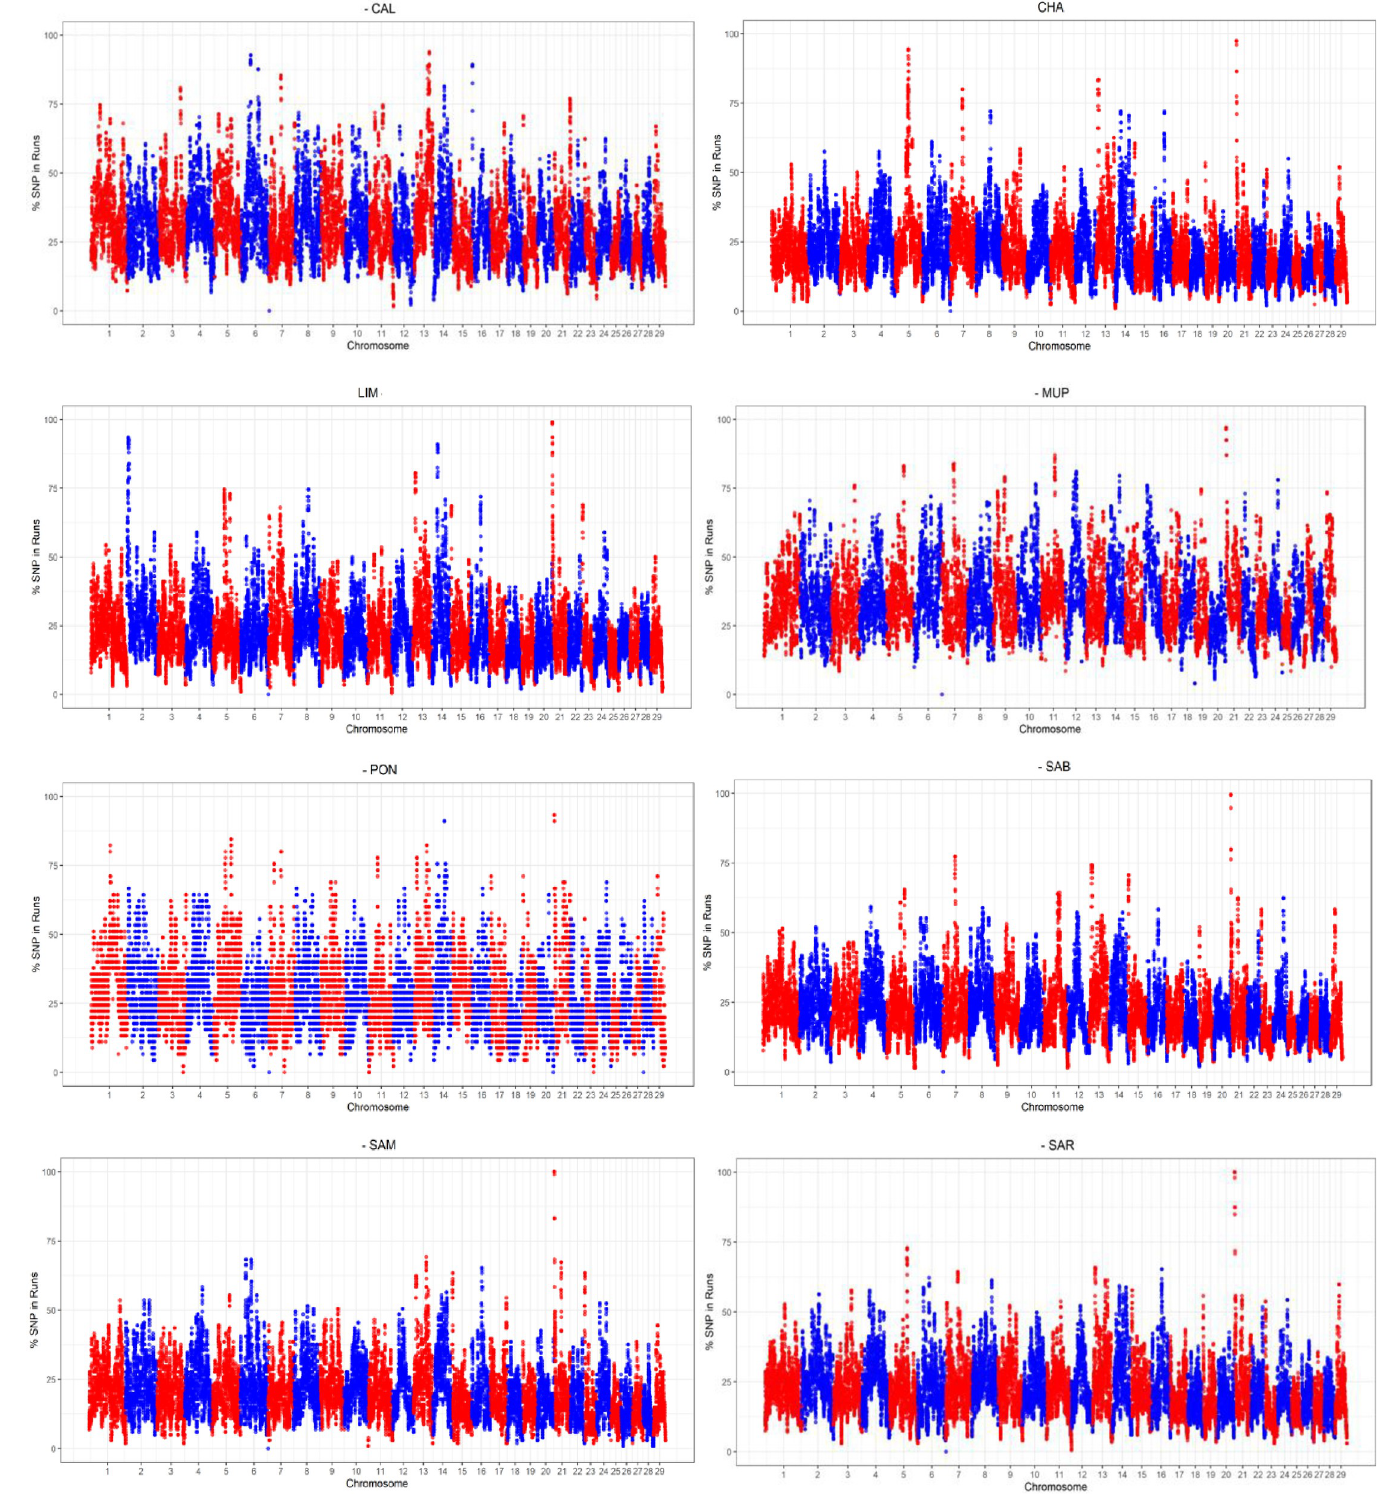
Fig 7. Manhattan plots of the distribution of ROH in the eight cattle breeds. The x-axis is the SNP position and the y-axis shows the frequency (%) at which each SNP was observed in ROH across individuals (CAL = Calvana; CHA = Charolais; LIM = Limousine; MUP = Mucca Pisana; PON = Pontremolese; SAB = Sardo Bruna; SAM = Sardo Modicana; SAR =